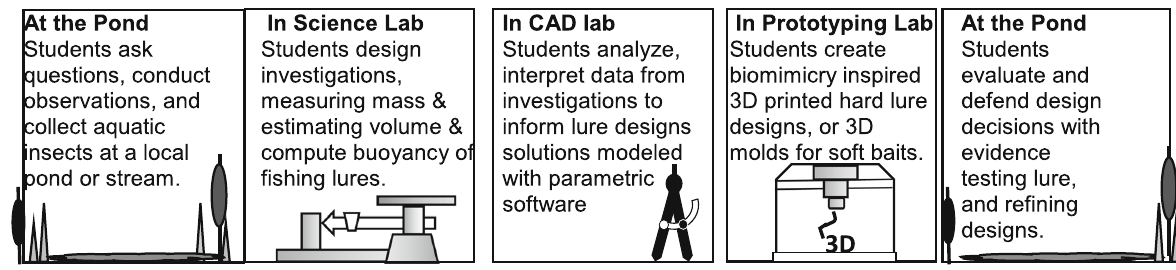
Fig. 2 D-Bait Lesson Activities: Science and Engineering Practices (Kelley, 2019: Adapted from NRC, 2011; NRC, 2012; NGSS Lead States, 2013)